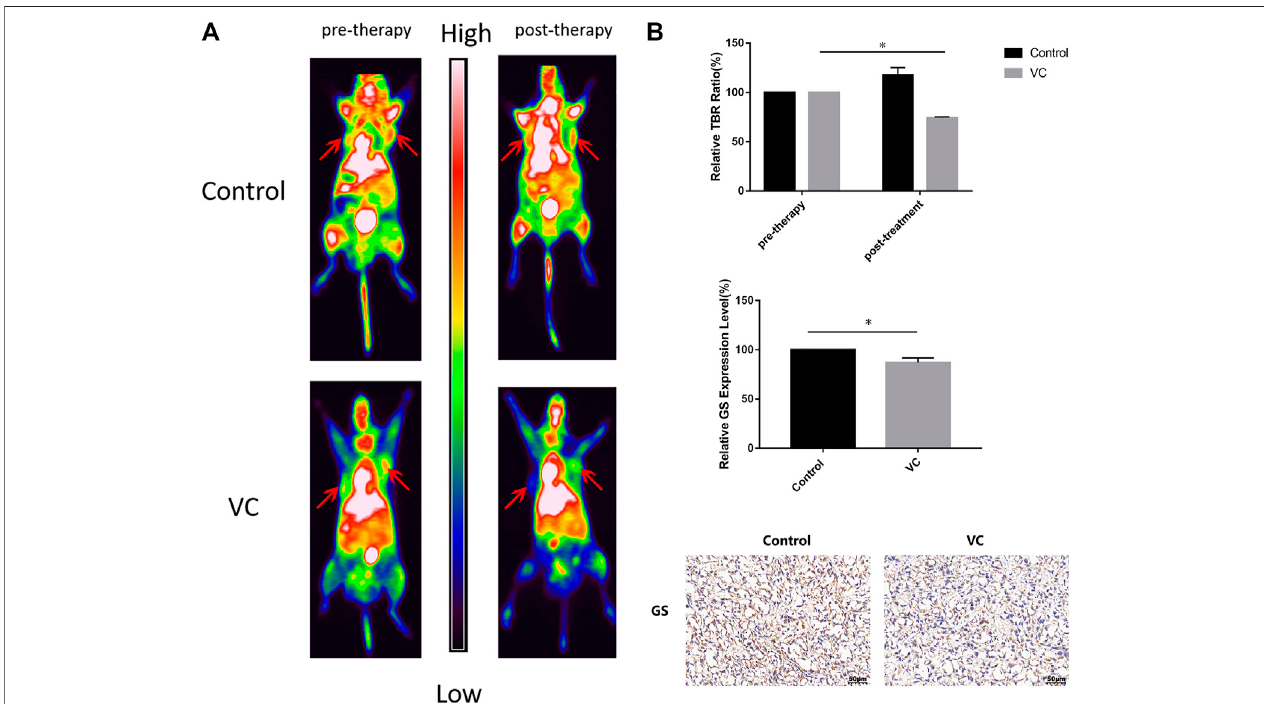
FIGURE7| Functional 13N-ammonia PET/CT imaging of PC3 xenografts in vivo shows asigni fi cant reduction in 13N-ammonia uptake under VC treatment. (A) Tumor 13N-ammonia uptake in treated and control mice. 13N-ammonia PET/CT were conducted before (day 0) and 3 days after therapy initiation. Right panels, representative PET/CT scans showing change of tumor tracer uptake (red arrows). (B) Tumor-to-background ratio (TBR) was calculated and served as an indicator of tracer uptake. Mean TBR of 13N-ammonia PET/CT was reduced in VC treated mice compared to controls. Immunohistochemical analyses showed the expression of GS decreased in the VC treatment specimens. All data are presented as means ± SEM, * p < 0.05, n (cid:2) 3. VC, Vitamin C; GS, glutamine